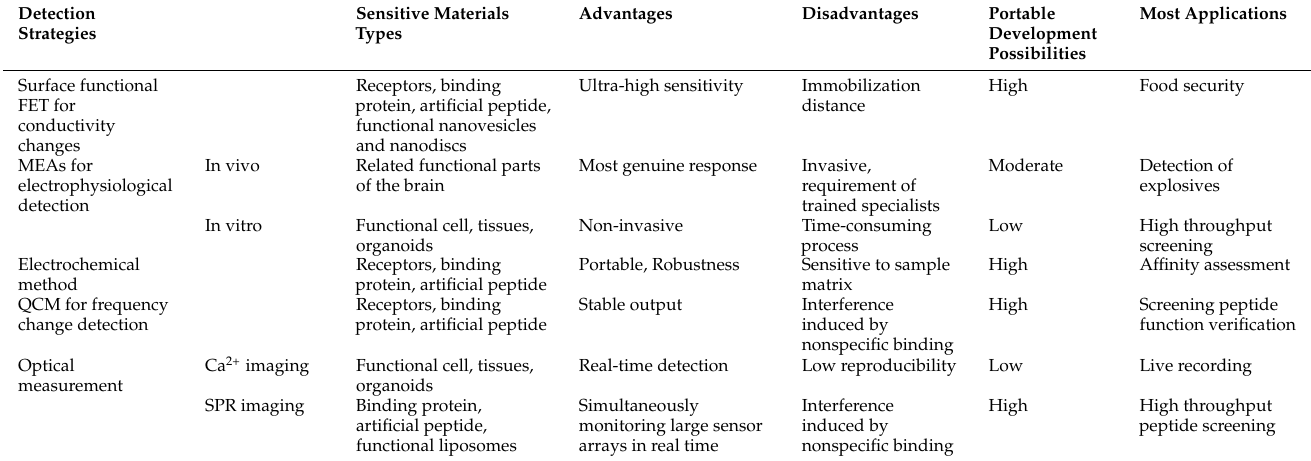
Table 5. Comparison of different biomimetic strategies based on existing research strategies.